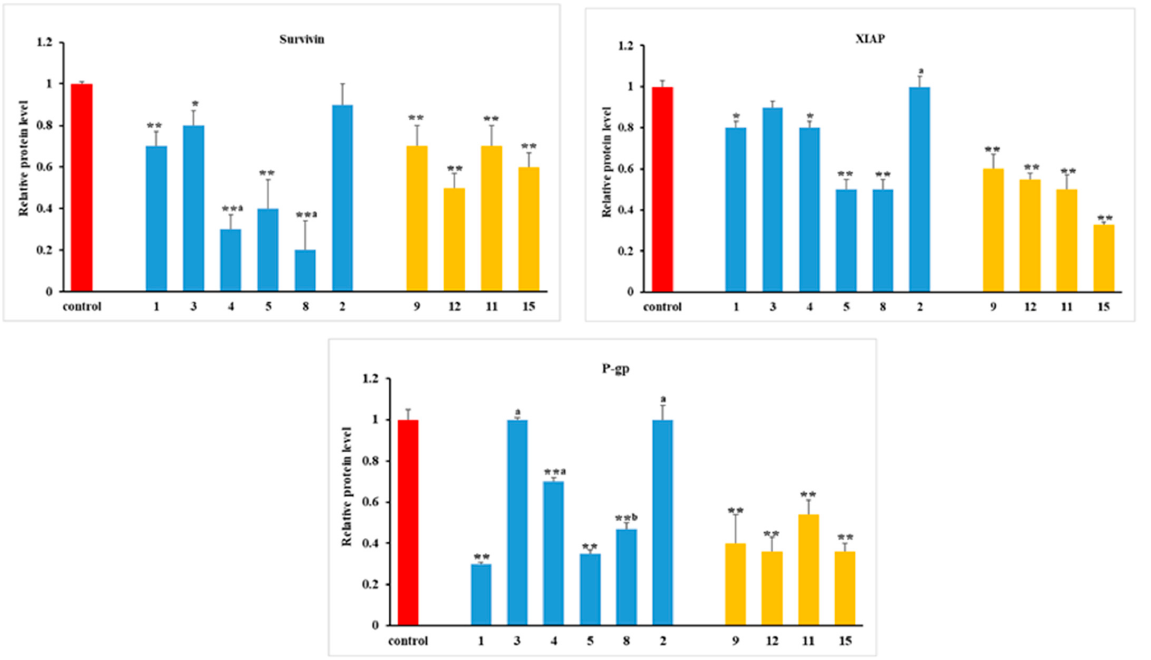
Figure 2. Western blotting analysis of the levels of Survivin, XIAP, and P-gp in HL60R cells. The cells were treated for 24 h with different compounds. Relative protein level (mean ± standard error of three experiments). Differences when treatments are compared to the control: ** p < 0.01, * p < 0.05; derivates versus precursors: a p < 0.05 (Survivin and XIAP), a p < 0.001 and b p < 0.05 (P-gp) (one-way ANOVA followed by Tukey’s test).